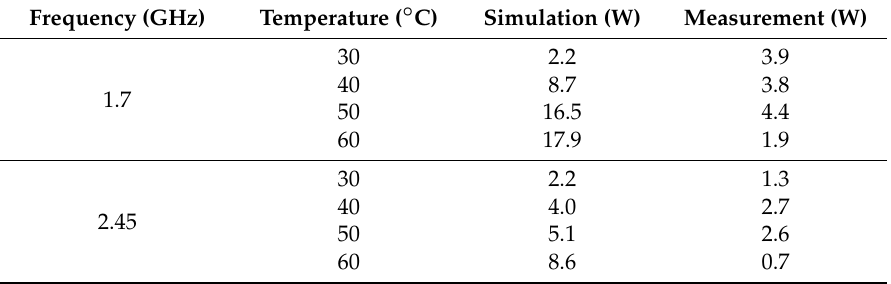
Table 3. Comparison of reflected power for the water between simulations and